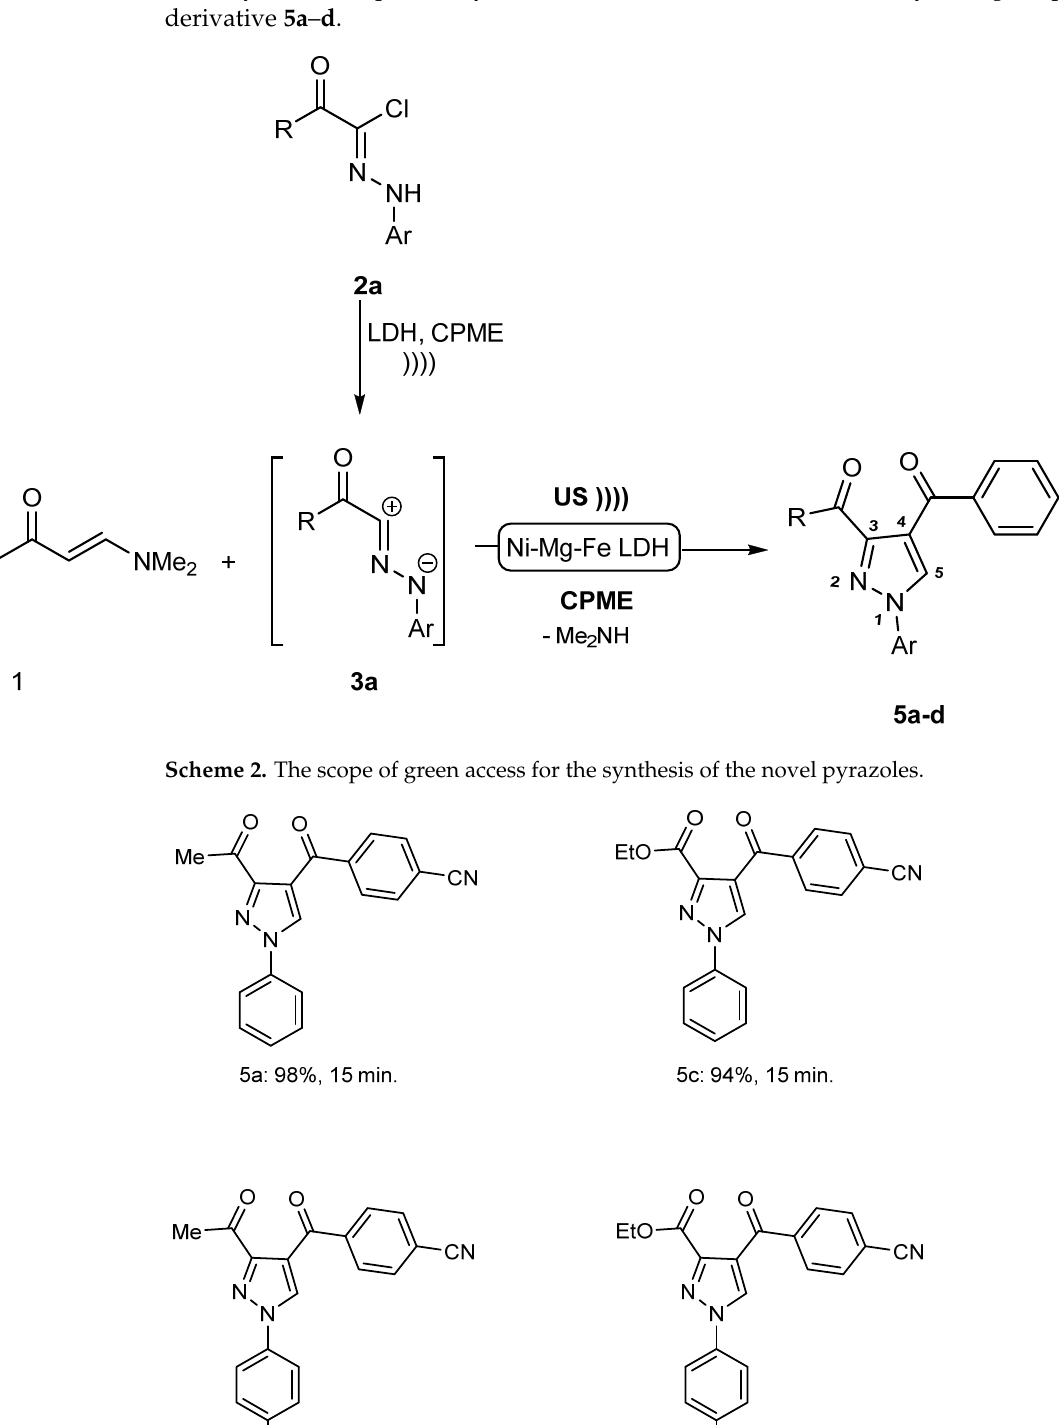
derivative 5a – d .